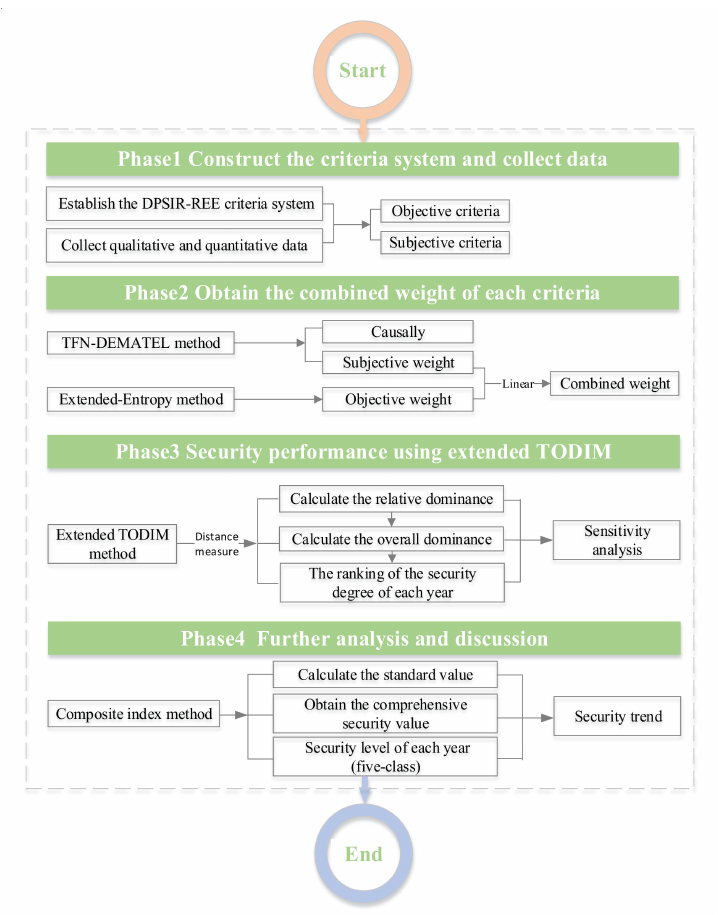
Figure 2. Security performance evaluation framework for Chinese REEs